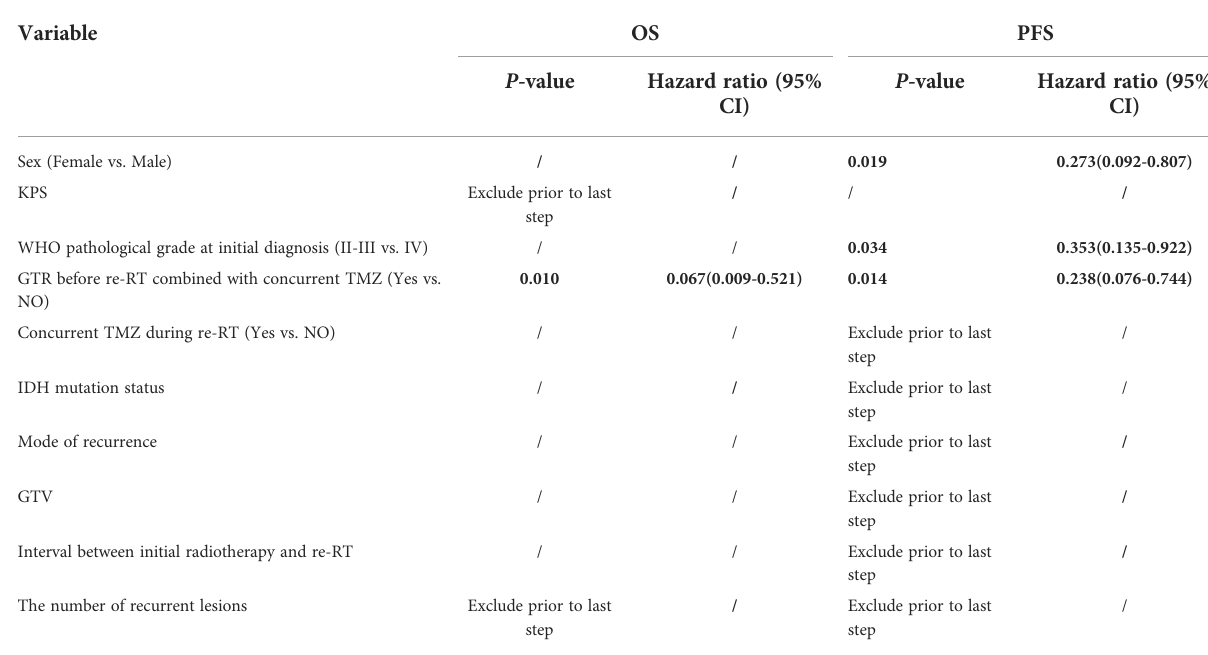
TABLE 4 Multivariate analysis for OS and